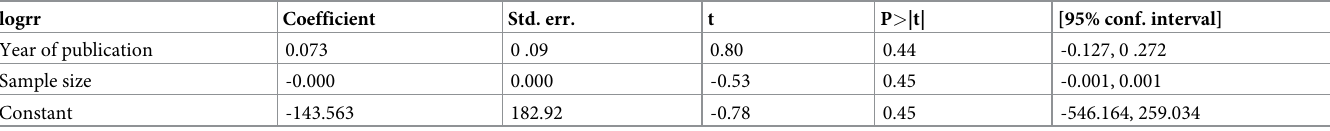
Table 2. Meta-regression using publication year and sample size for tinea capitis in Ethiopian schoolchildren.